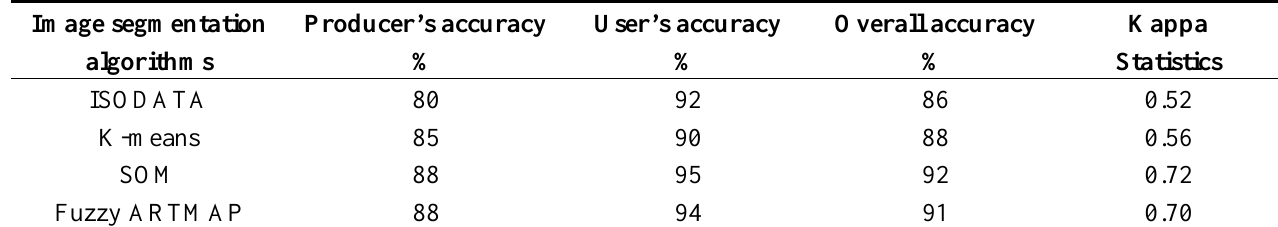
Table 2. The classification accuracy report of four image segmentation algorithm applications on Air-Pilot Farm 2009 NAIP